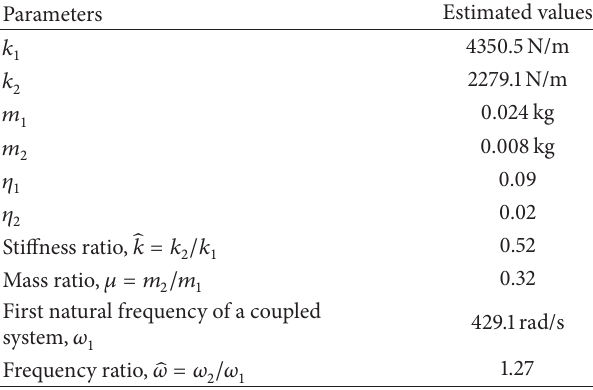
Table 3: Two-degree-of-freedom model system parameters esti- mated by fitting the two-degree-of-freedom model equations with the measured data from the